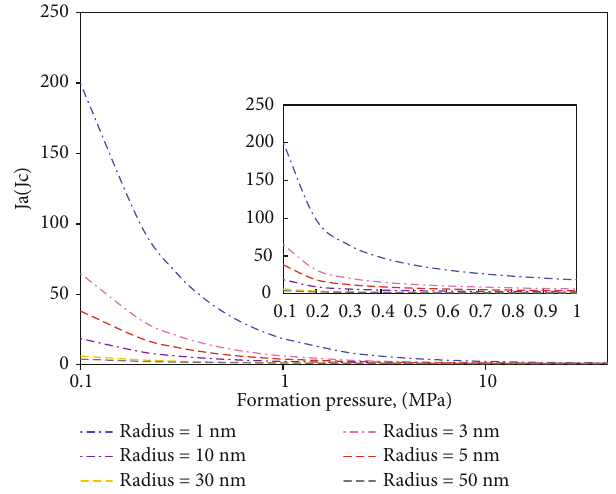
Figure 6: Gas transport capacity in di ff erent nanopores during the production